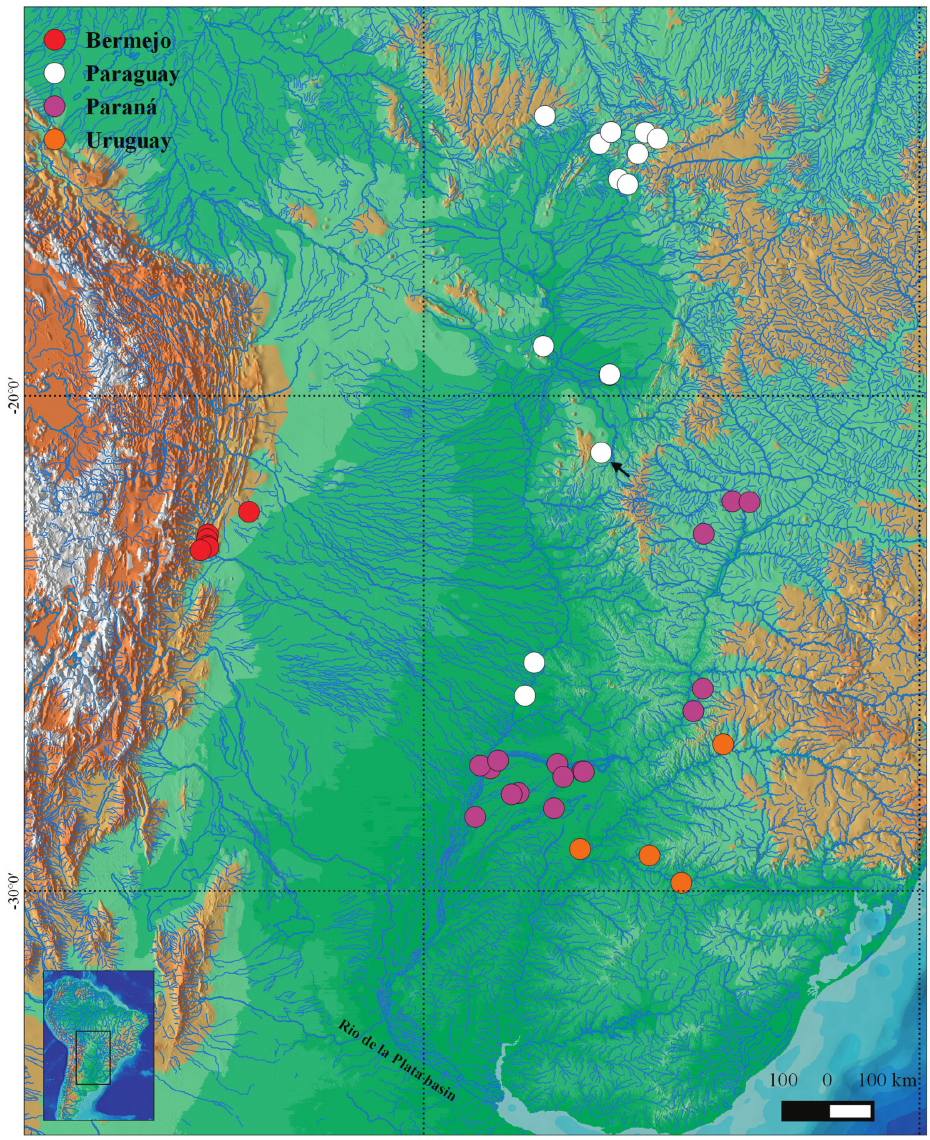
Fig. 1. Map showing the distributional range of Moenkhausia bonita across the rio de la Plata basin (based on the examined specimens). Black arrow indicates type